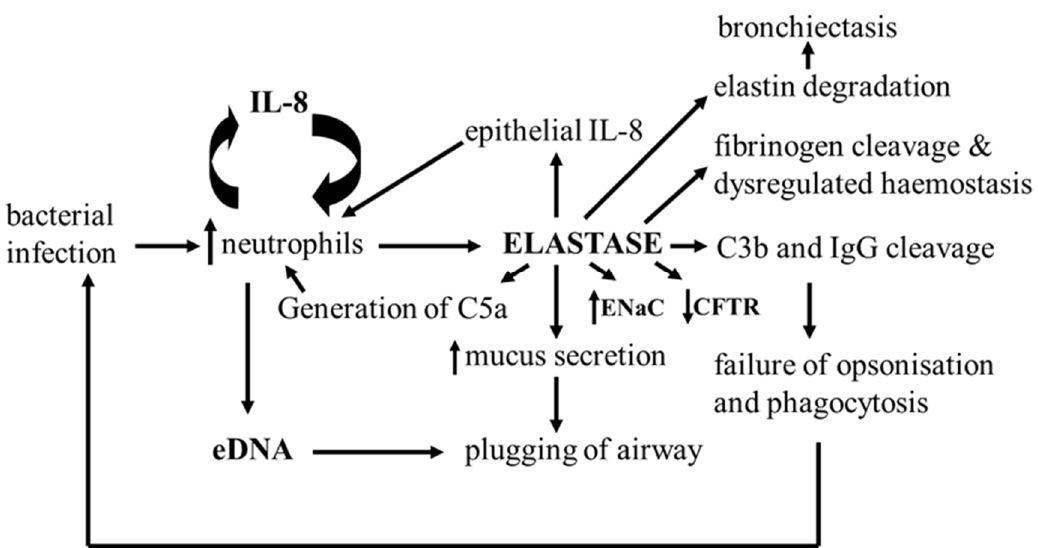
Figure 3. Neutrophil elastase activity is central to the pathogenesis of CF lung disease. Neutrophil elastase is a potent mucus secretagogue and elastolytic tissue enzyme that cripples the immune system and limits airway coagulation, leading to cycles of IL-8-driven infection and in fl ammation that are di ffi cult to break [175,177–179].